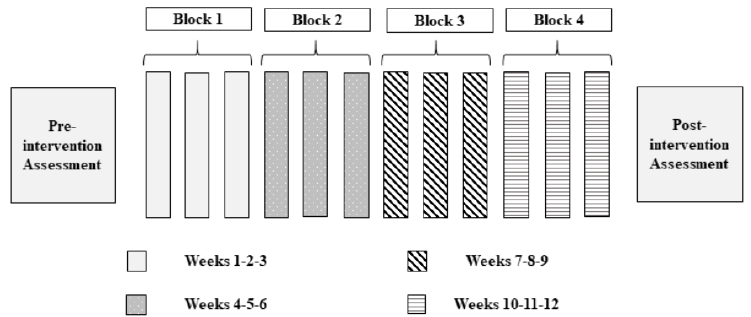
Figure 2. Intervention program based on active video games and motor games (weeks).